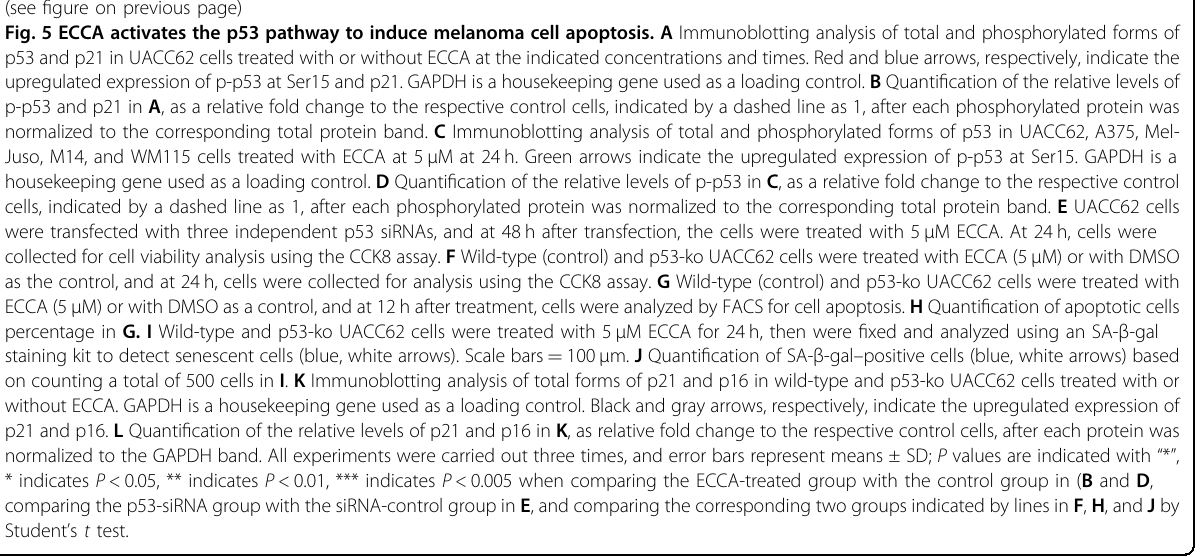
(blue arrows) (Fig. 6A, B). The ECCA-induced phos- phorylation of p38-MAPK occurred at 1 µM ECCA and of JNK at 0.5 µM ECCA at 6 h, earlier than the activation of p53 (Fig. 6A – C). To con fi rm the involvement of p38-